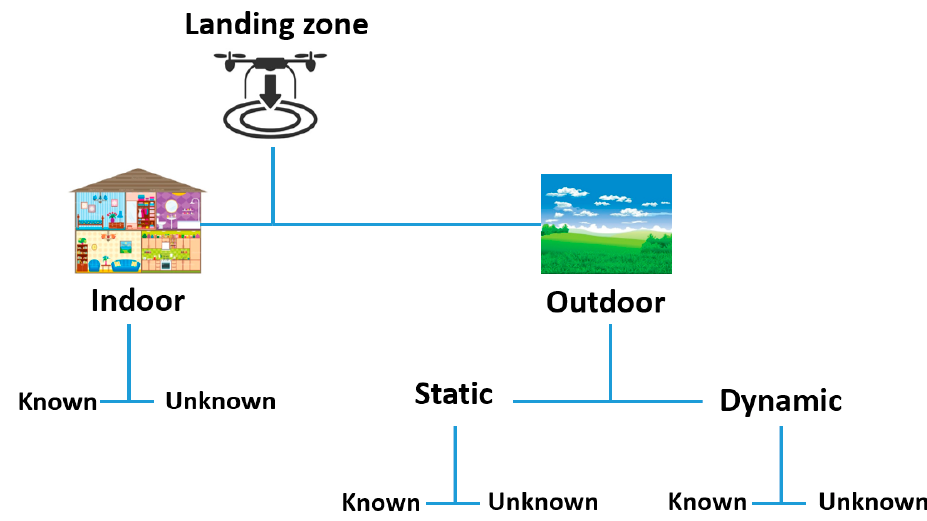
Figure 8. Different types of landing zones adapted from [70].